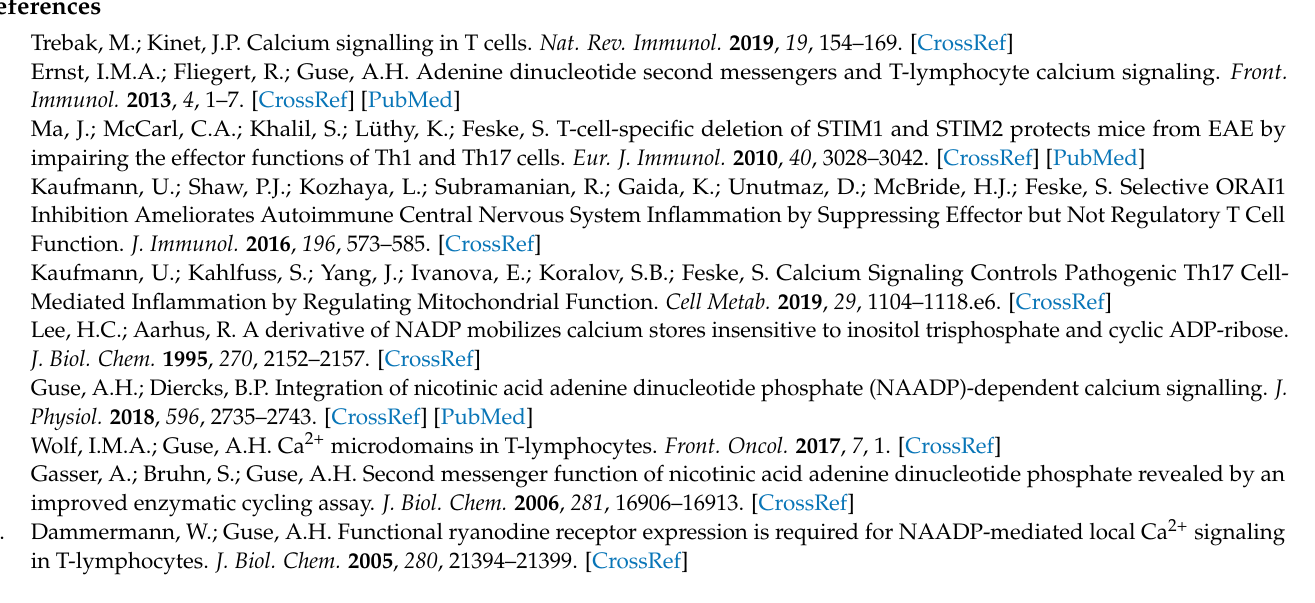
Figure S2: NAADP inhibition by trans-Ned 19 does not decrease the viability of resting CD4 + T cells in vitro. Figure S3: NAADP inhibition by trans-Ned 19 promotes the differentiation of Th1 and Th17 cells upon stimulation with antigen. Figure S4: CD4 + T cell in vitro differentiation in the presence of NAADP antagonist